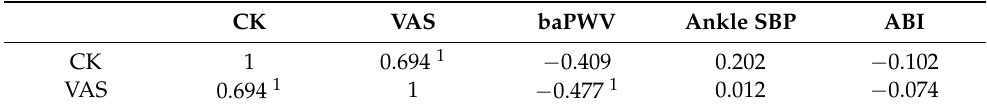
Table 2. Correlation between changes in indirect markers of muscle damage and soreness and arterial stiffness variables at 24 h after COD exercise protocol. CK VAS baPWV Ankle SBP ABI CK 1 0.694 1 − 0.409 0.202 − 0.102 VAS 0.694 1 1 − 0.477 1 0.012 −